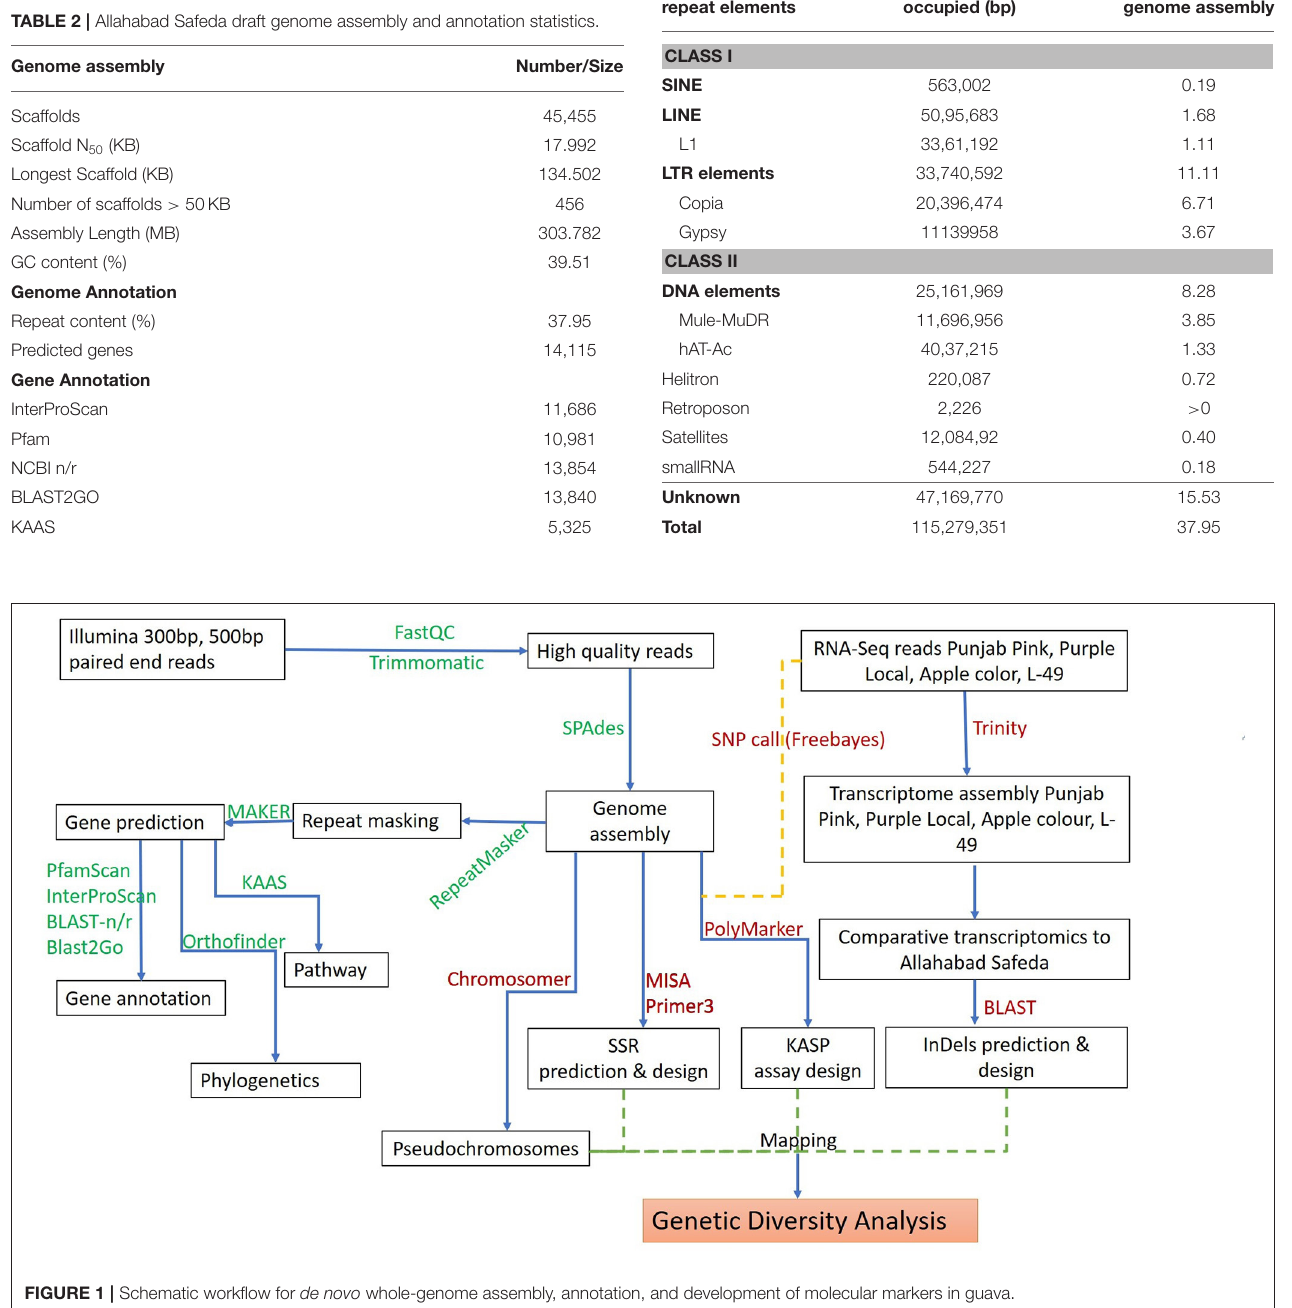
Frontiers in Plant Science |